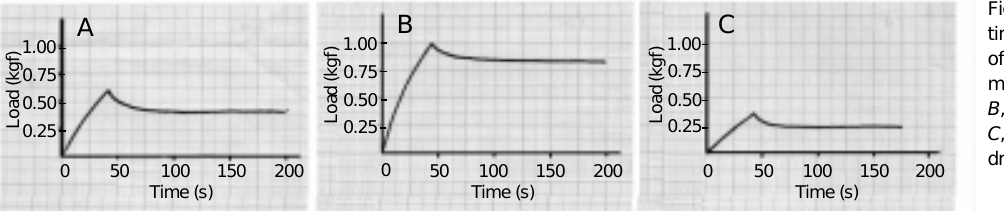
time curves obtained as a result of the indentation tests. A , Nor- mal articular cartilage surfaces; B , control repaired surfaces, and C , surfaces repaired with the hy- drogel